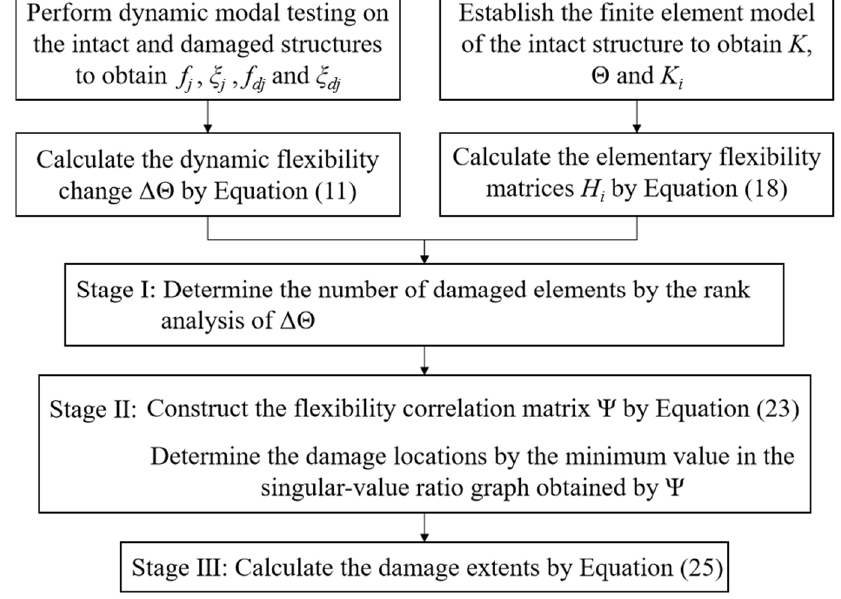
Figure 1. The flow chart of the complete method.